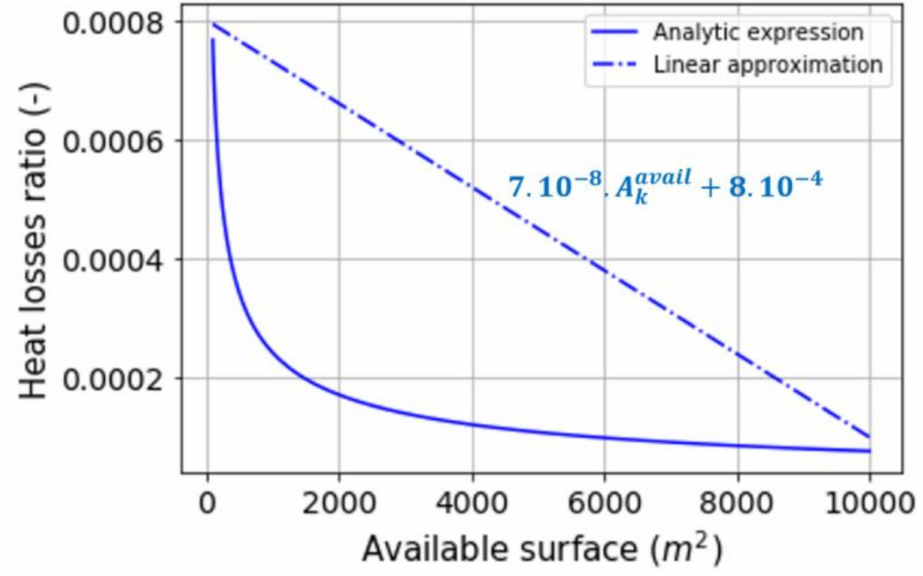
Figure 7. Value of the heat losses coefficient α loss as a function of the available surface. Maximum Thermal Capacity on the Vertices and Edges of the